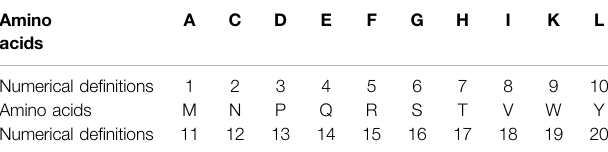
TABLE 1 | Numerical de fi nitions of amino acids.